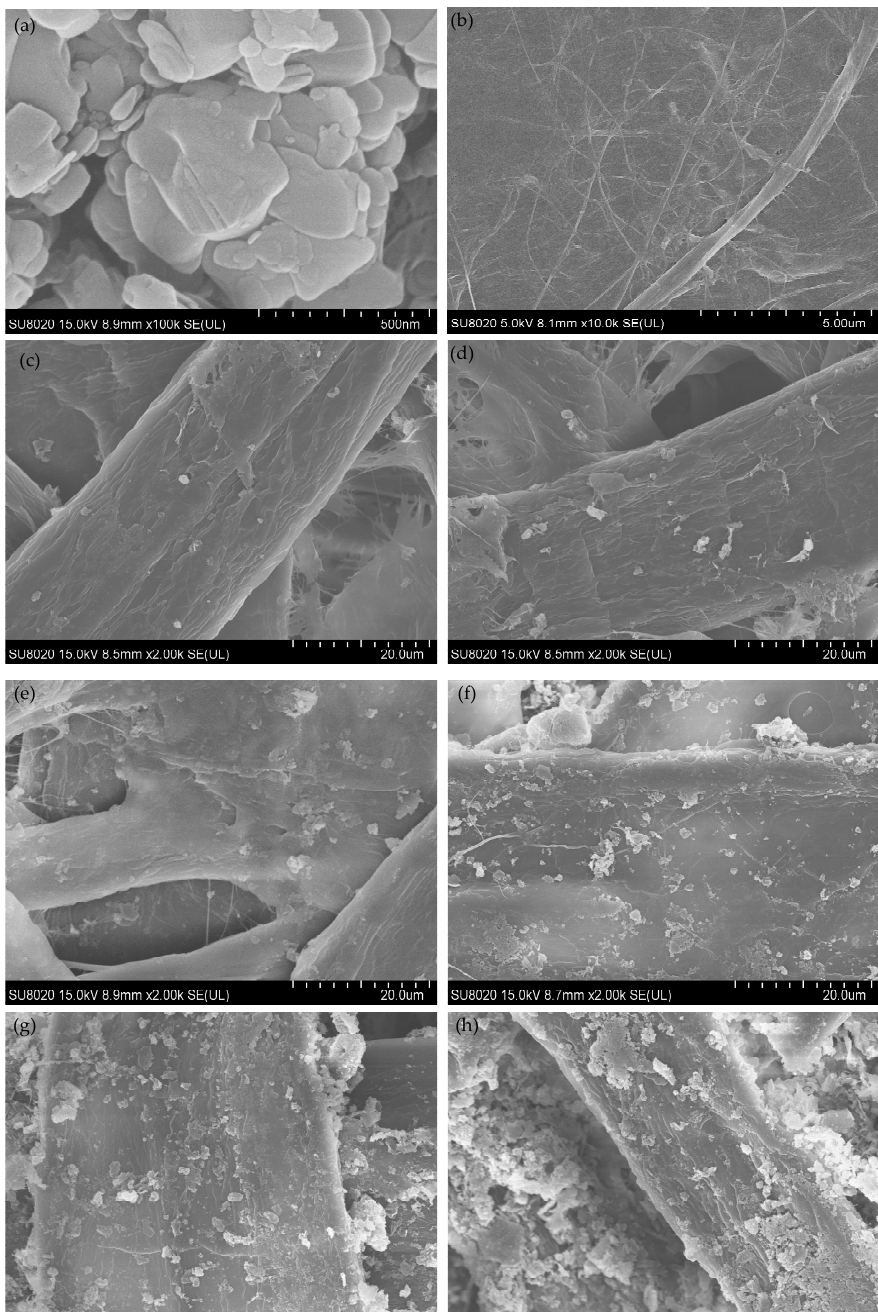
Figure 3. ( a ) SEM micrographs of nano-h-BN ( b ) SEM micrographs of unmodified pressboard; ( c ) SEM micrographs of modified pressboard with 2.5 wt % h-BN; ( d ) SEM micrographs of modified pressboard with 5 wt % h-BN; ( e ) SEM micrographs of modified pressboard with 10 wt % h-BN; ( f ) SEM micrographs of modified pressboard with 20 wt % h-BN; ( g ) SEM micrographs of modified pressboard wit 40 wth % h-BN; ( h ) SEM micrographs of modified pressboard with 50 wt % h-BN;.